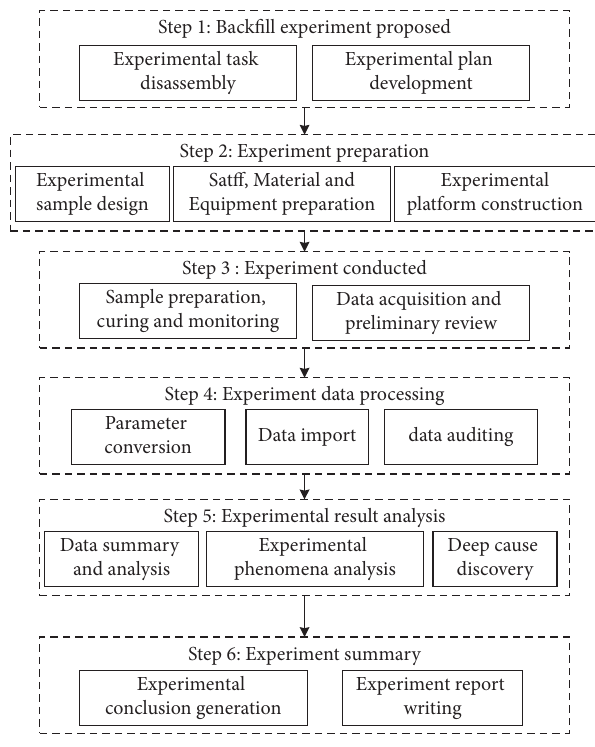
Figure 1: Flow chart of backfill